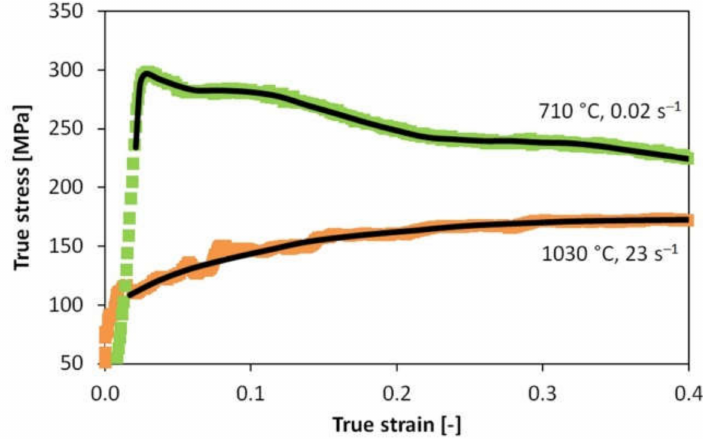
Figure 9. Example of flow curves smoothing (coloured points correspond to experimental values, black lines are the result of smoothing and interpolation).